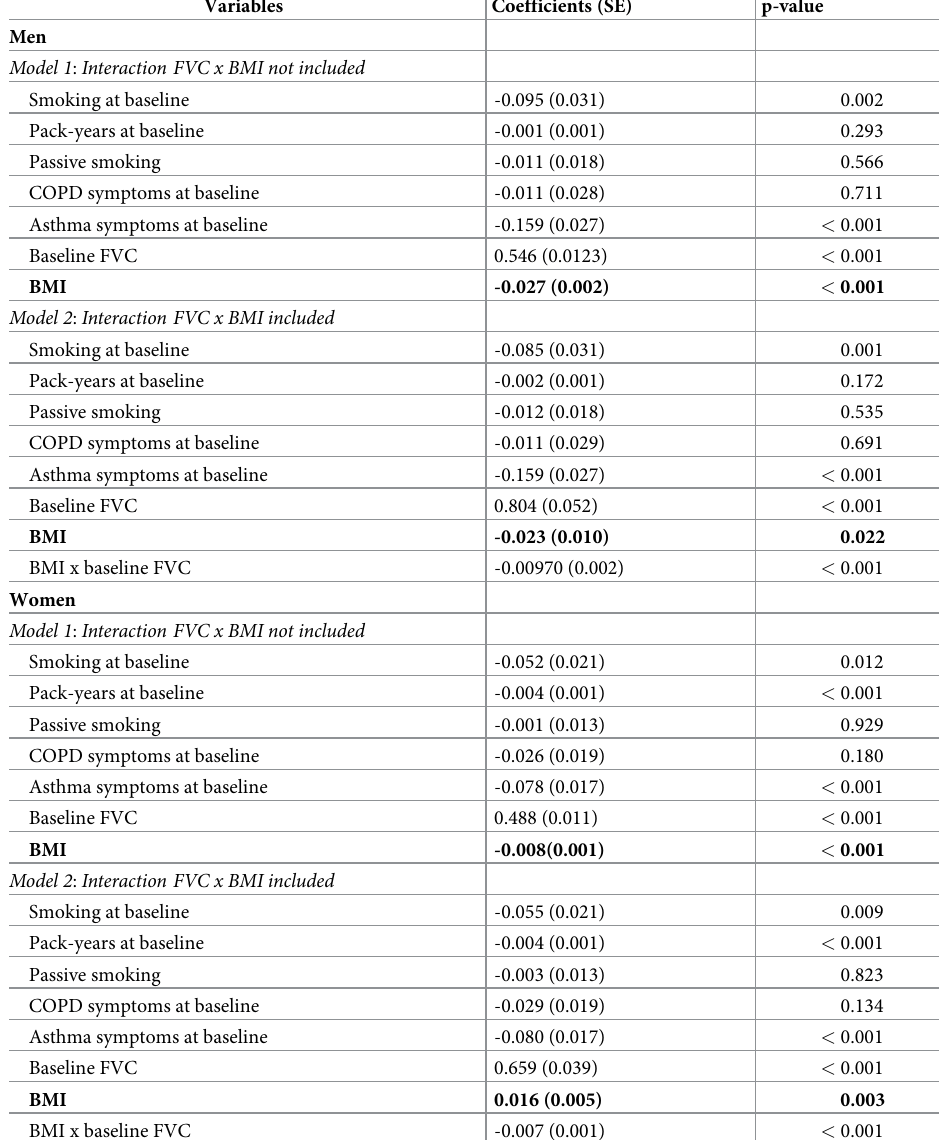
Table 5. The effects of BMI change during follow-up, adjusted for baseline